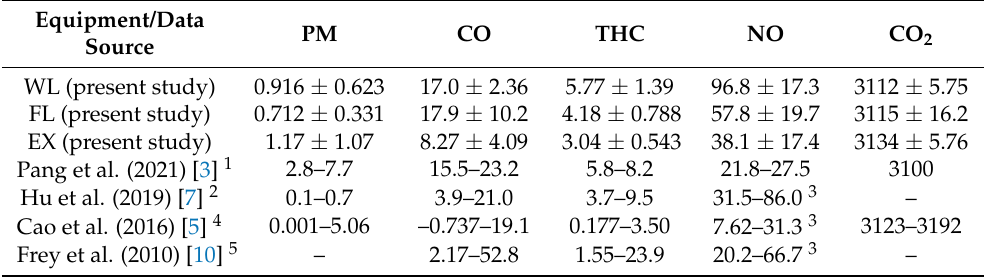
Table 2. Fuel-specific emission factors (g/kg-fuel) of test machines compared with those reported in the